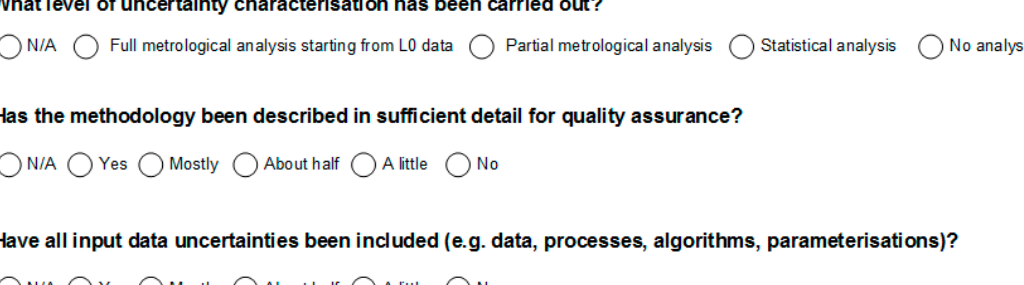
Figure 2. Example of the evaluation questions within the Uncertainty Characterisation Quality Indicator (QI) section that an independent expert Reviewer would answer based on the information provided by the product producer in the QAT.